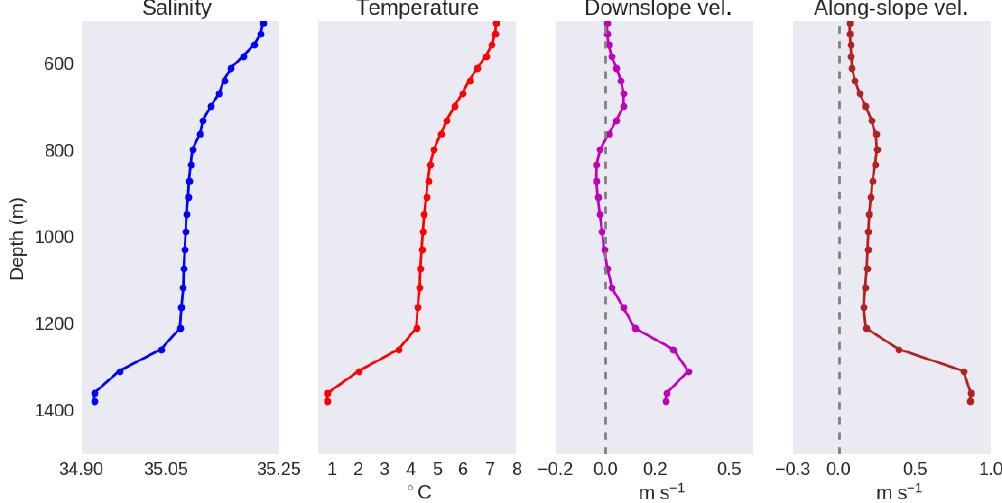
Figure 15. Vertical profiles of the physical properties of the overflow plume in simulation DSO60.L150 (hour 10 on 1 February of year 5) at section 16 for the location indicated with a white-rimmed dot in Fig. 6b. (a) Salinity, (b) temperature, (c) cross-slope velocity, and (d) along- slope